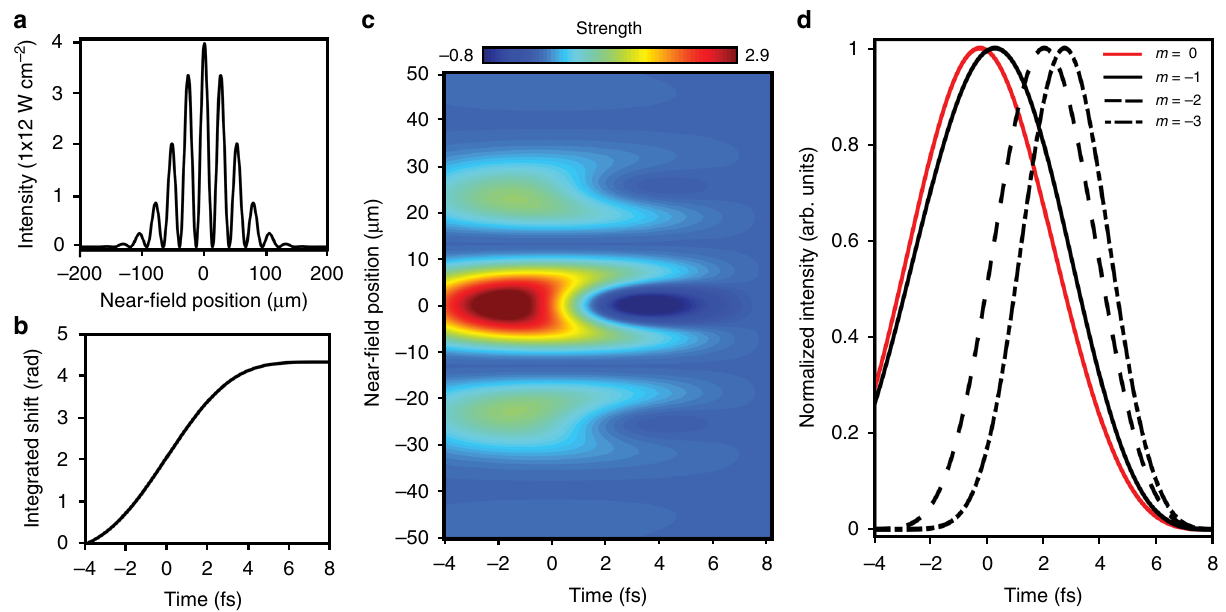
Fig. 5 Model of AC Stark phase grating accumulation and nonlinear signal generation. a Spatially modulated intensity pro fi le generated by two crossed near-infrared (NIR) pulses. b The calculated NIR-induced AC stark shift plotted as a function of real time, where time zero corresponds to the time at which the extreme ultraviolet (XUV) pulse interacts with the system and the peak of the NIR pulse. c A false color plot shows the amplitude of the dipole moment modulated by both the AC Stark phase grating and an amplitude grating in the near fi eld as a function of time. Later times exhibit an increased modulation depth. d In the far fi eld, different grating orders are plotted as a function of time during the NIR